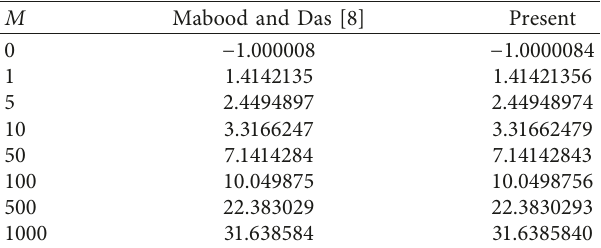
Table 2: Comparison of − f ″ ( 0 ) for various values of M when � δ � S � 0. f w f